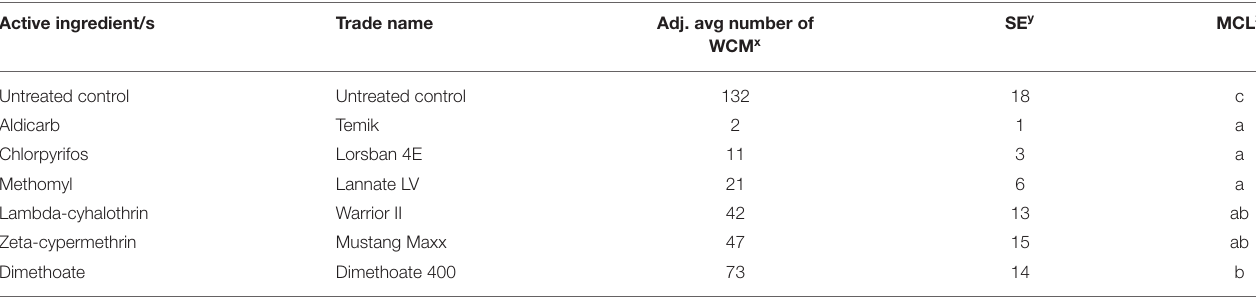
TABLE 2 | Effect of carbamate, organophosphate, and pyrethroid treatments on average WCM total per plant. Active